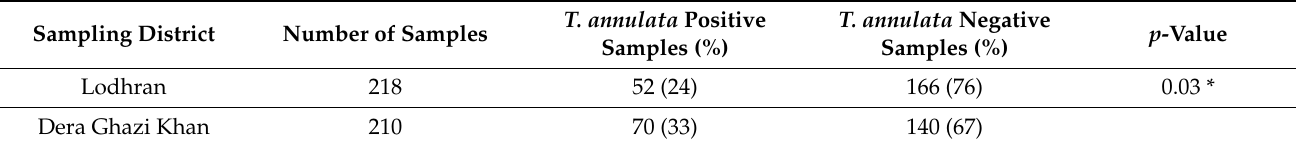
Table 1. Comparison of Theileria annulata prevalence in blood samples of cattle collected from Lodhran and Dera Ghazi Khan Districts. % prevalence is shown in parenthesis. p -value indicates the results of chi-square test, calculated for parasite